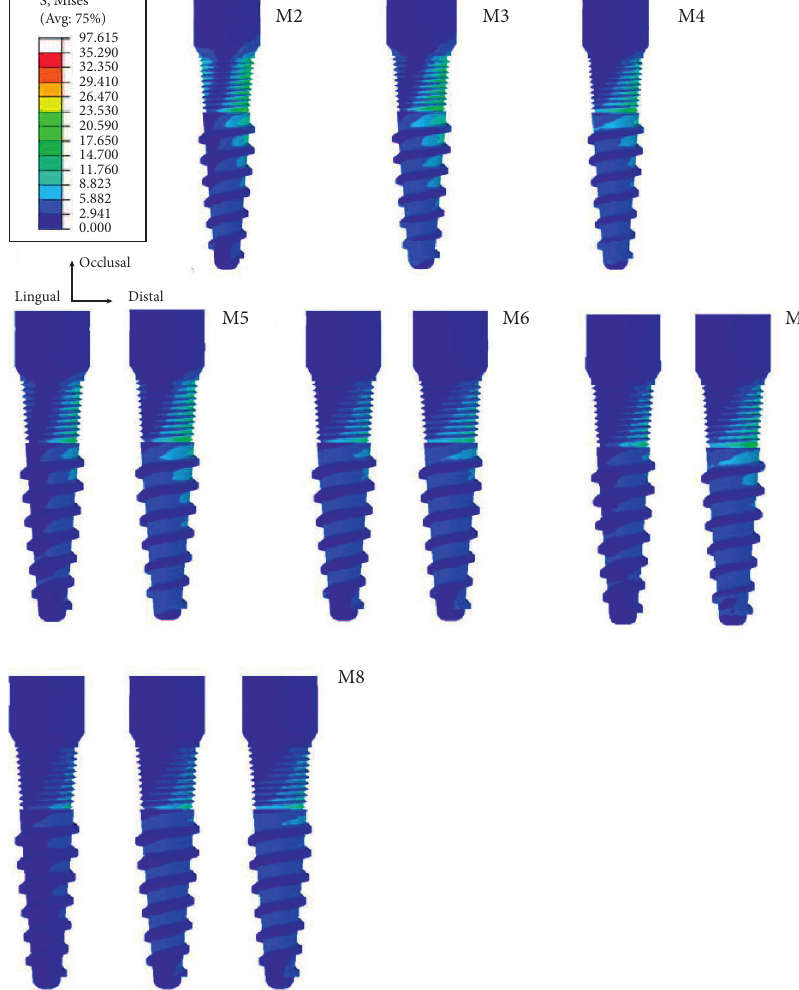
Figure 5: Stress distribution on the missal surface of the dental implant.